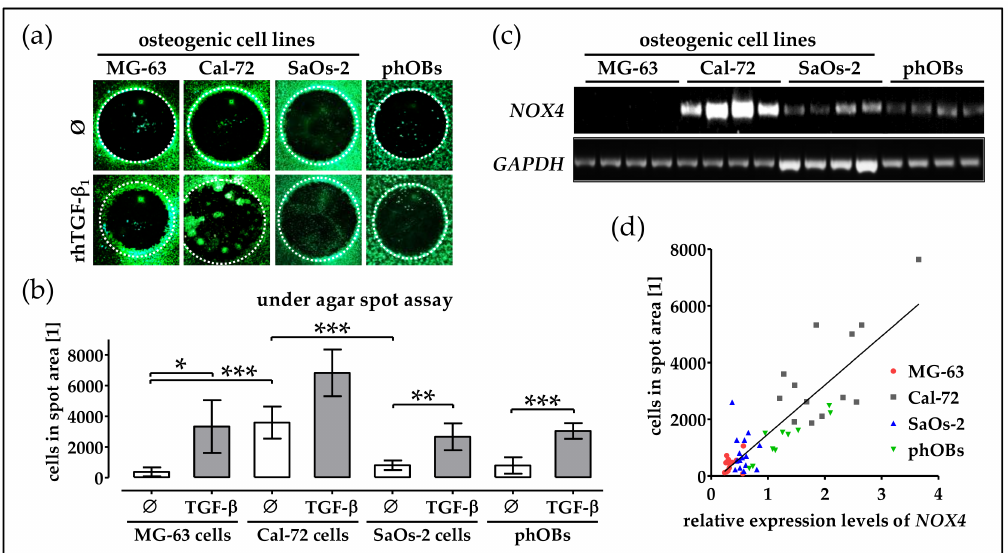
Figure 7. Migration of osteogenic cell lines and phOBs is inducible with rhTGF- β 1 and correlates with their NOX4 expression. Migration of osteogenic cell lines (MG-63, Cal-72 and SaOs-2) and phOBs was investigated by under agar spot assay ( N ≥ 4, n ≥ 4/ ± 5 ng/mL rhTGF- β 1 . ( a ) Representative microscopic images for the under agar spot assay (12.5 × magnification). ( b ) For the under agar spot assay, the number of cells in the spot area was determined from microscopic images with the help of the ImageJ software. Cells were visualized with Calcein-AM stain for living cells. ( c ) Basal NOX4 mRNA levels were determined by semi-quantitative RT-PCR. ( d ) Correlation of between the NOX4 expression levels and the migration capacity of the cells (R 2 = 0.7323). Data are represented in bar diagrams (mean ± 95% C.I.). * p < 0.05, ** p < 0.01, and *** p < 0.001 as